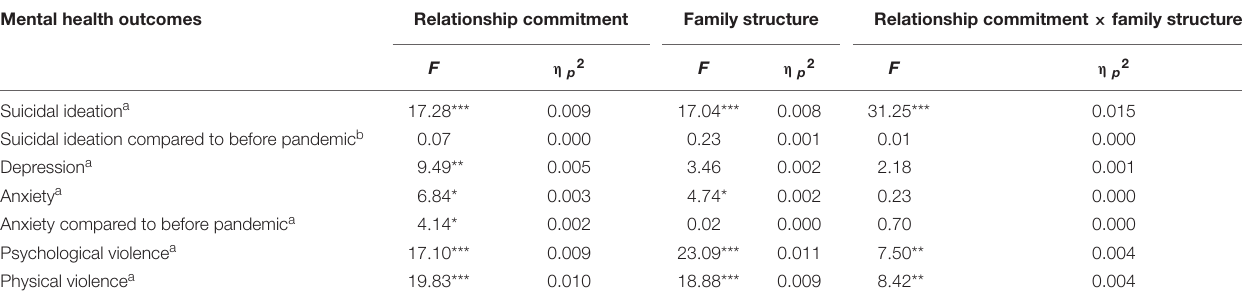
Table entries are F values and effect sizes ( η p2 ) of analyzes of variance of mental health outcomes with regard to relationship commitment (high vs. low commitment), family structure (child vs. no child in household), and interactions between these factors estimated with weighted data, *p < 0.05; **p < 0.01; ***p < 0.001